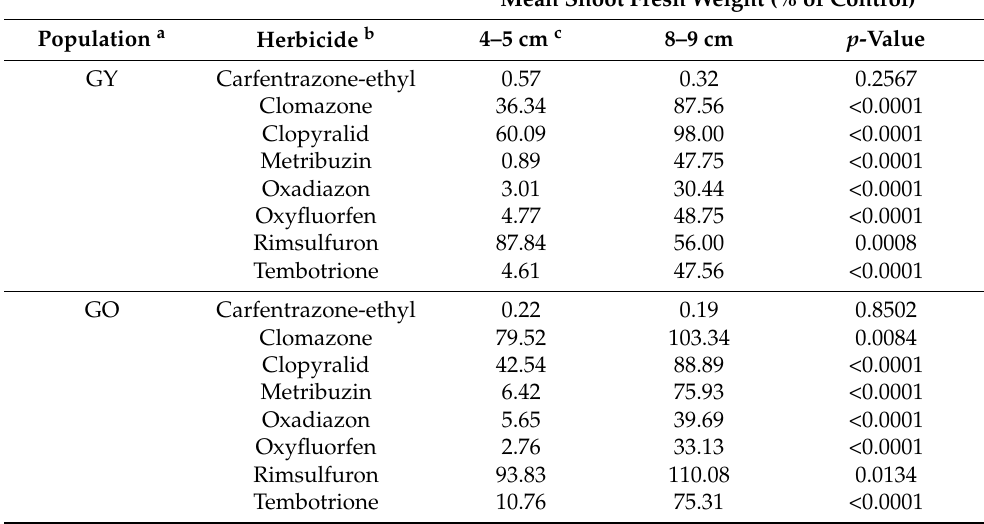
Table 1. Differences in mean shoot fresh weight among Solanum rostratum populations in response to various